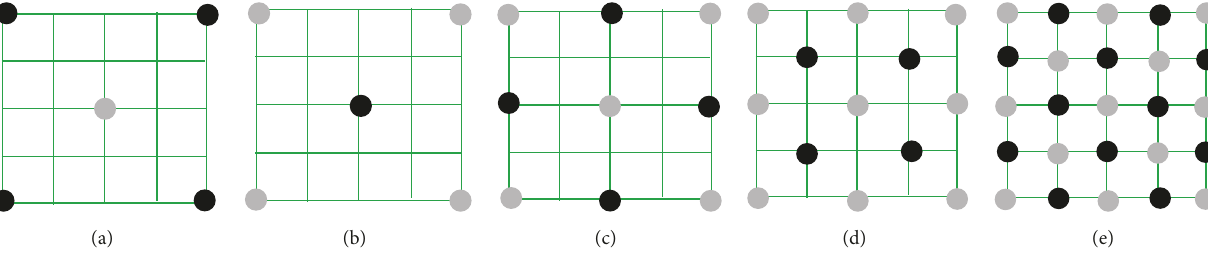
Figure 1: Diamond-square